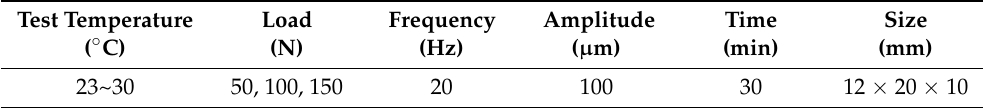
Table 4. Experimental parameters of fretting wear test.